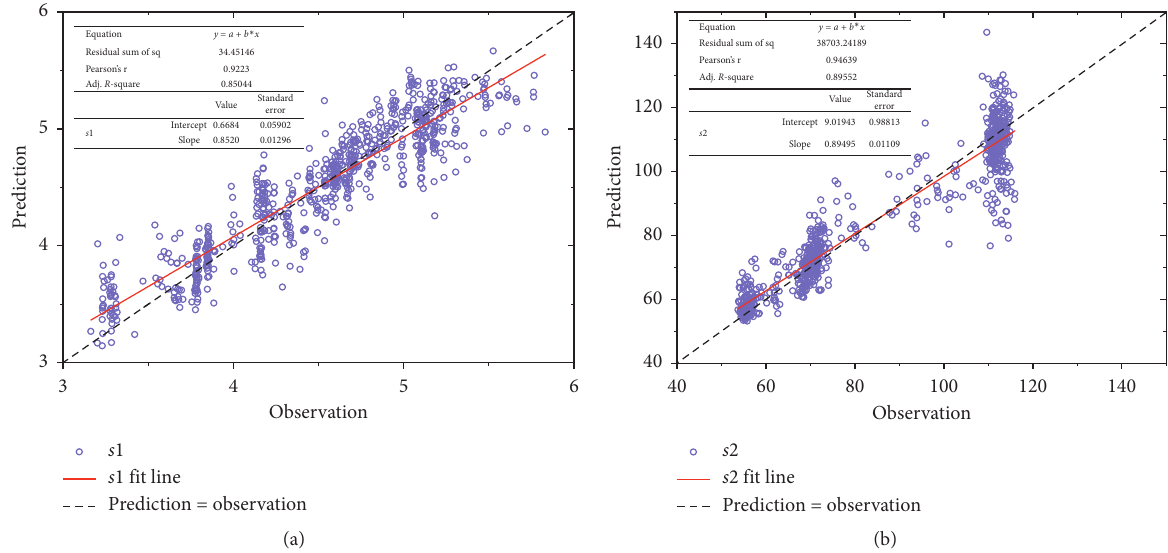
Figure 4: Scatter plot of observations and surrogate model enabled predictions for different outputs of output parameters: (a) bubble chamber pressure ( s 1); (b) deviation angle ( s 2).